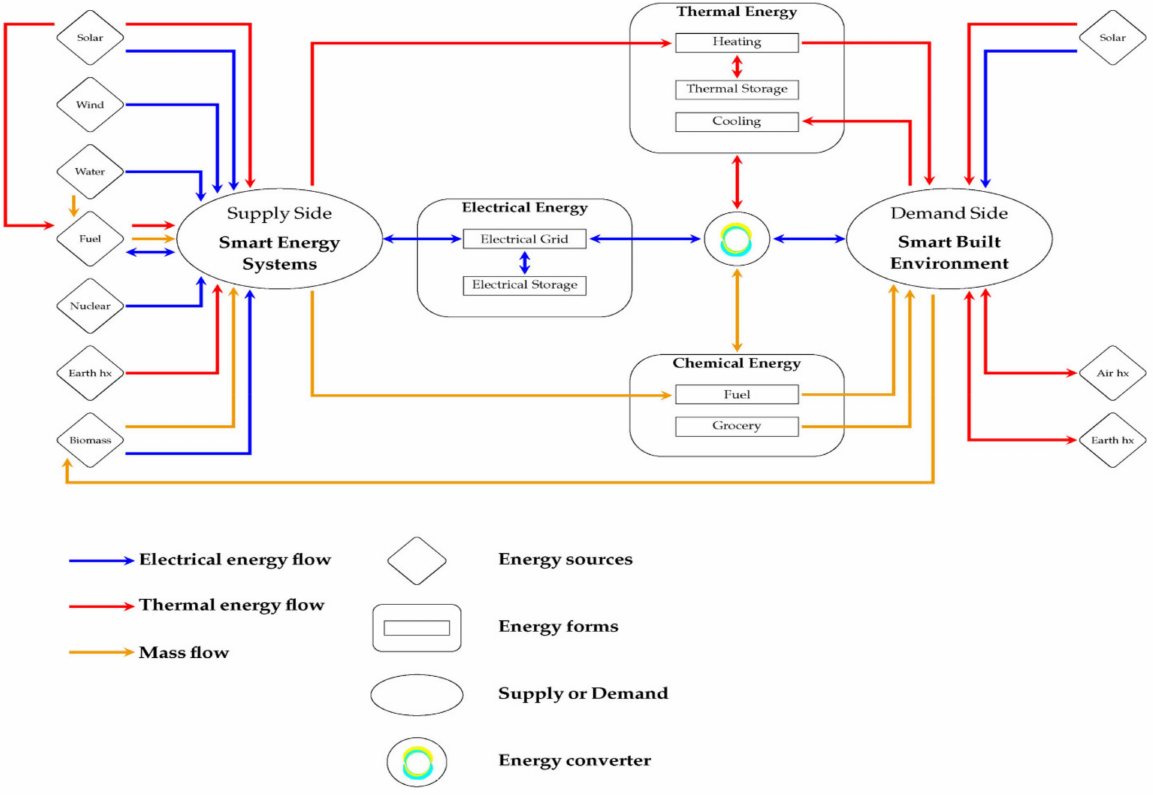
Figure 4. Energy flow charts between the supply side SESs and the demand side SBE [74] (Su